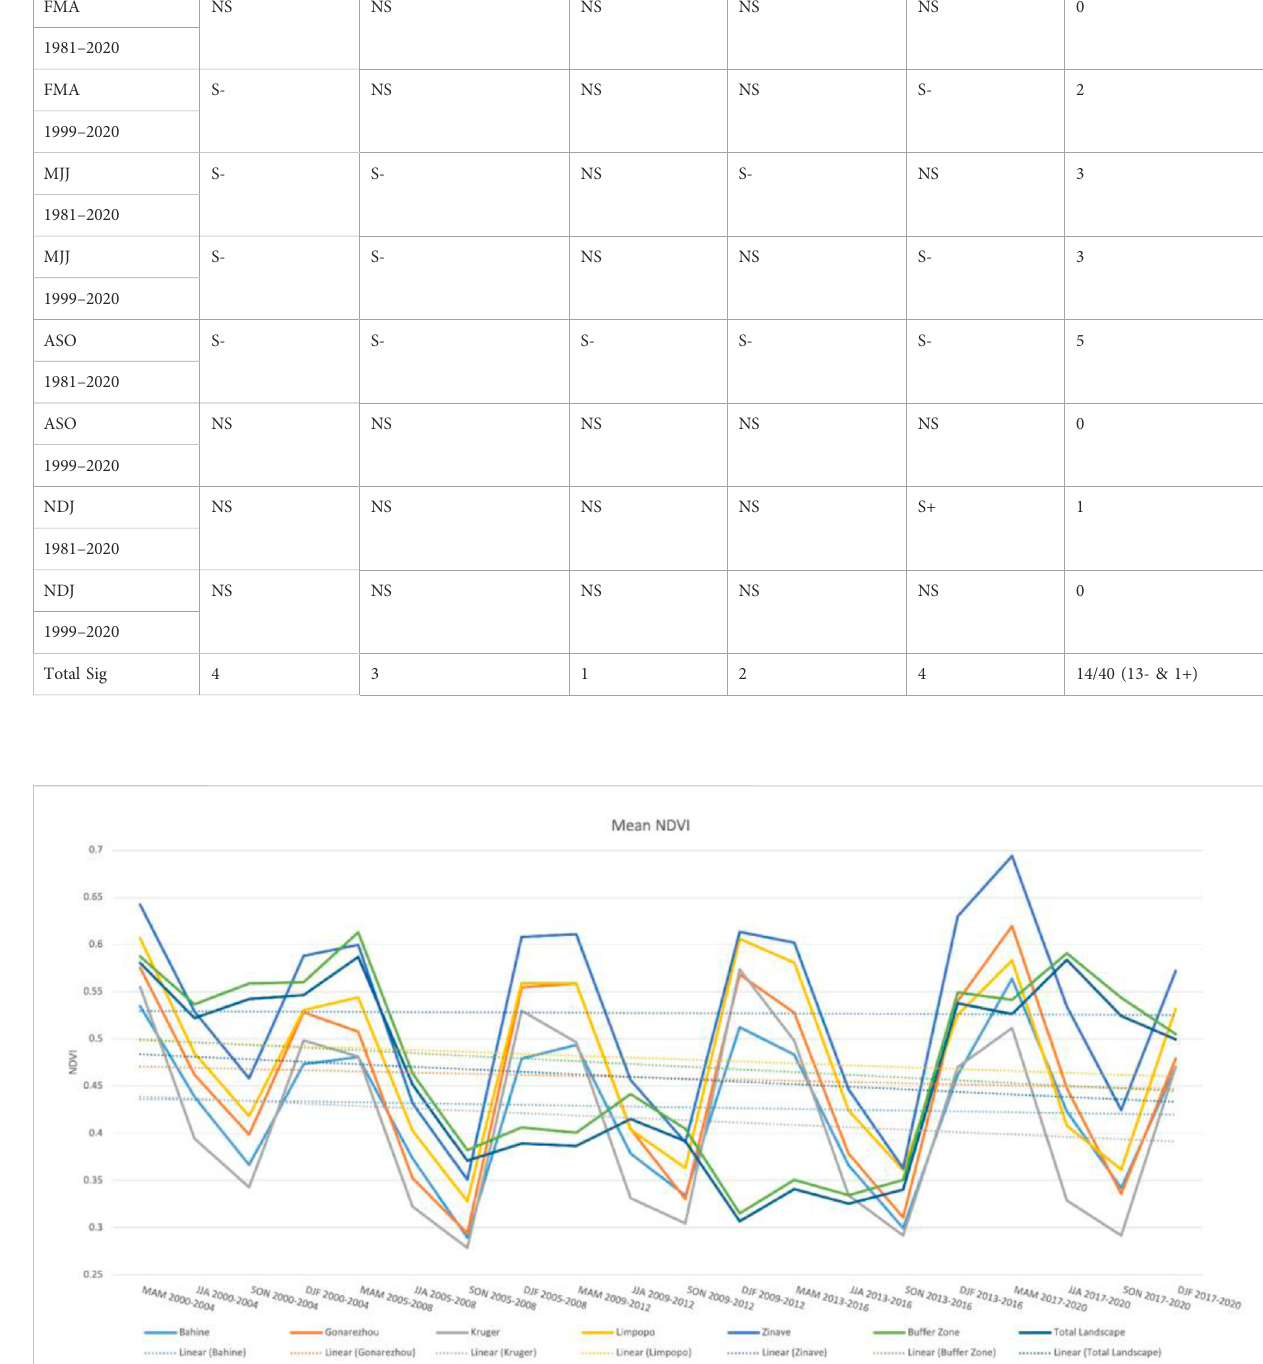
TABLE 3 Trends in Precipitation over time, ordered left to right for the parks with least to greatest mean annual precipitation, highlighting negatively signi fi cant trend (S-), positively signi fi cant trend (S+), or no signi fi cant trend (NS) in precipitation over different time periods, seasons, and parks through Z-scores. Bahine Gonarezhou Kruger Limpopo Zinave Total Sig